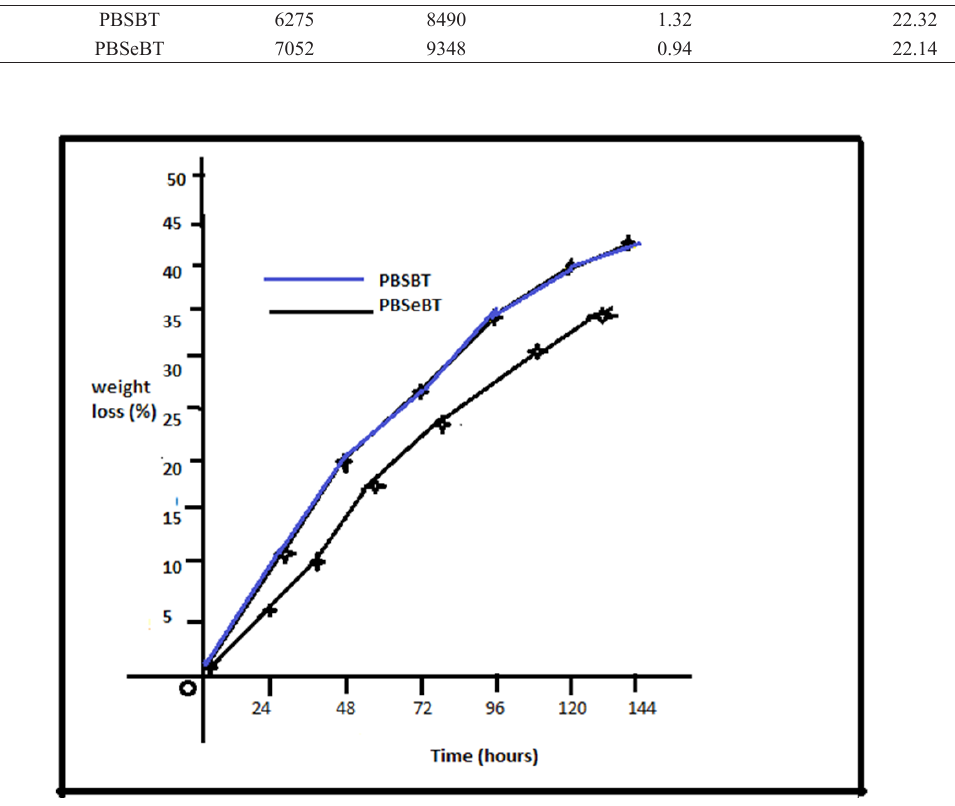
Fig.7 Alkali degradation of copolyester, PBSeBT and PBSBT